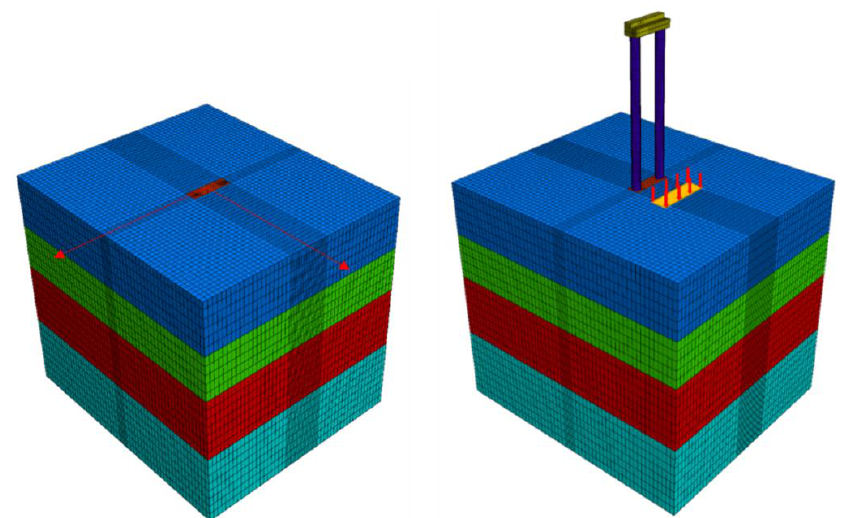
Figure 19. Applied temporary load.